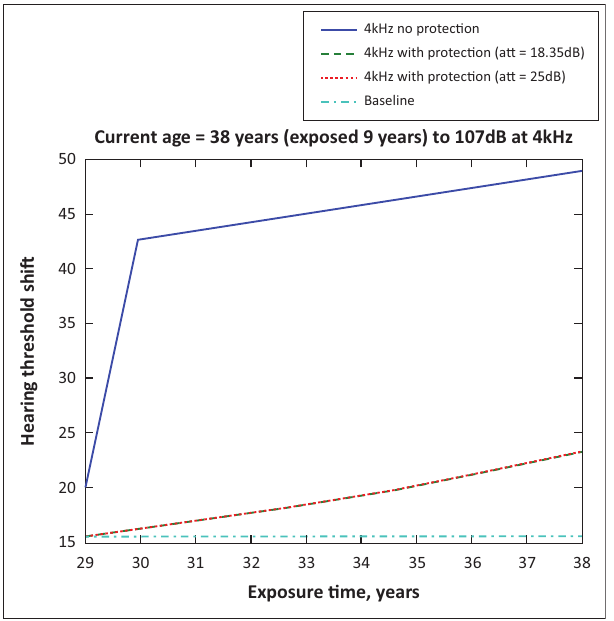
Source : Figure created using data from Moroe, N.F. (2018). Occupational noise-induced hearing loss in South African large scale mines: From policy formulation to implementation and monitoring . Doctoral thesis. Johannesburg: University of the Witwatersrand. FIGURE 7: Thirty-eight years old at 4000 Hz with exposure levels of 107 dB.